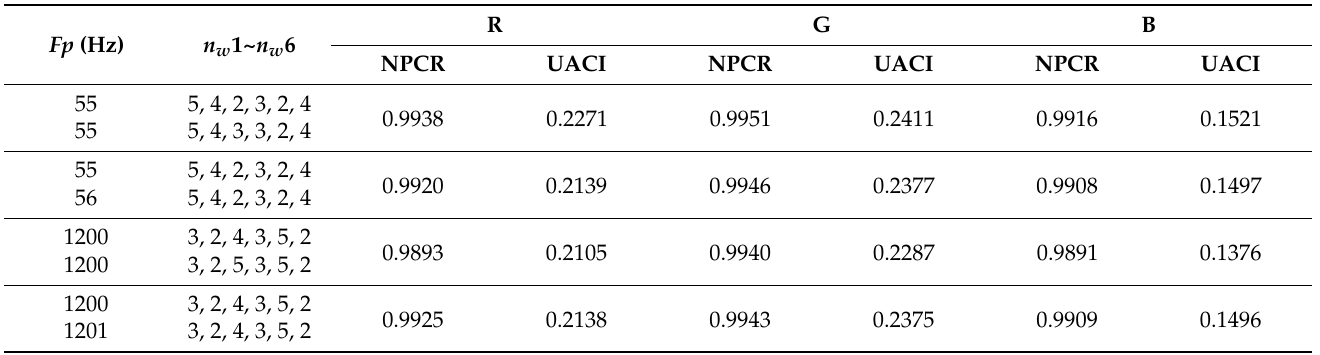
Table 6. The NPCR and UACI for the cipher images.